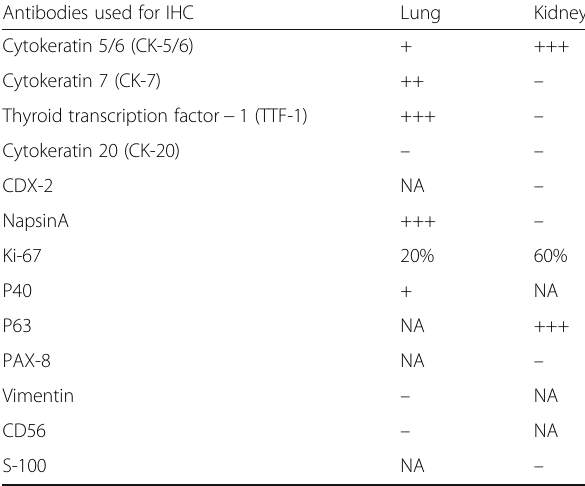
Table 1 Immunohistochemistry results for the lung and kidney tumors Antibodies used for IHC